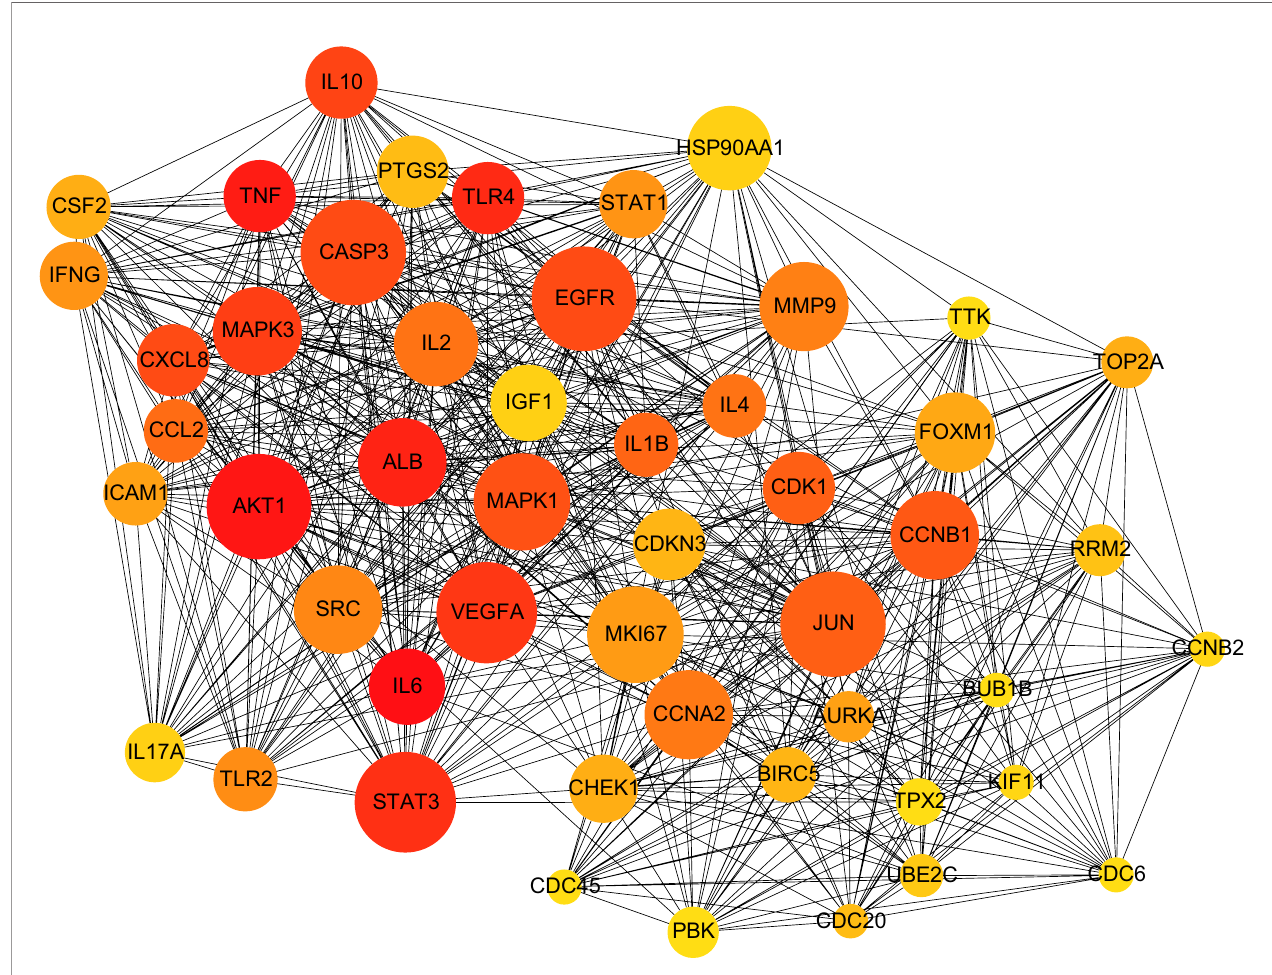
FIGURE 2 | PPI network of common targets between COVID-19 and dengue. In the fi gure, the circle nodes indicate genes, and edges specify interactions between